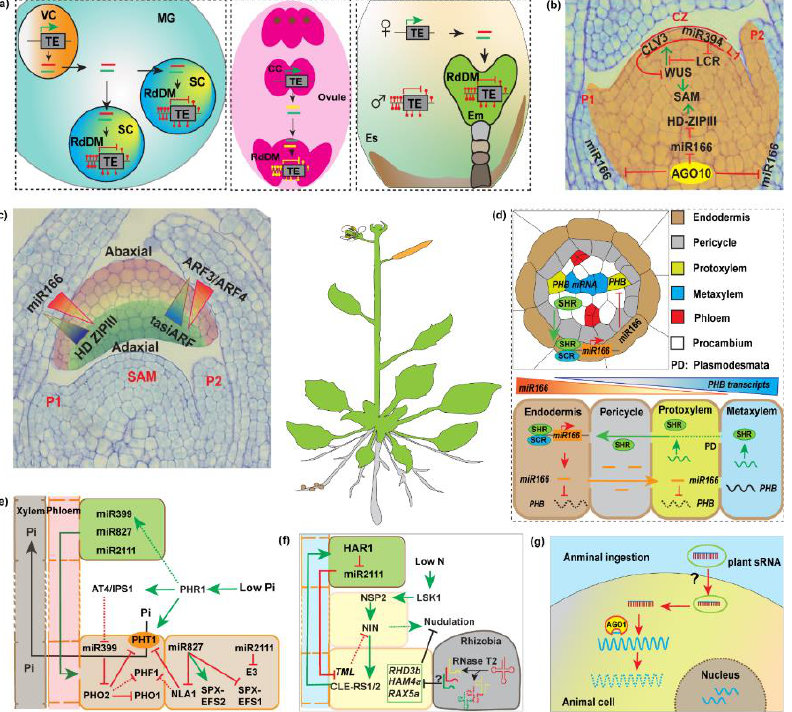
Figure 2. Functions of mobile sRNAs. ( a ), Mobile sRNAs regulate DNA methylation in recipient cells. In mature pollen grains (MG), the vegetative nuclei (VN) derived transposable elements (TEs) sRNAs are either targeting TE within VN or trafficking into sperm cells (SC) to silence TE by RNA-directed DNA methylation (RdDM), reinforcing TE silencing in gametes (left). In the mature embryo sac, similar to pollen grains, TE-derived siRNAs can move from the central cell (CC) to the egg cells (EC) to silence TEs (middle). During seed development, siRNAs highly produced in endosperm can (right). ( b ), Mobile miRNAs in Shoot Apical Meristem (SAM) niche maintenance. In the central